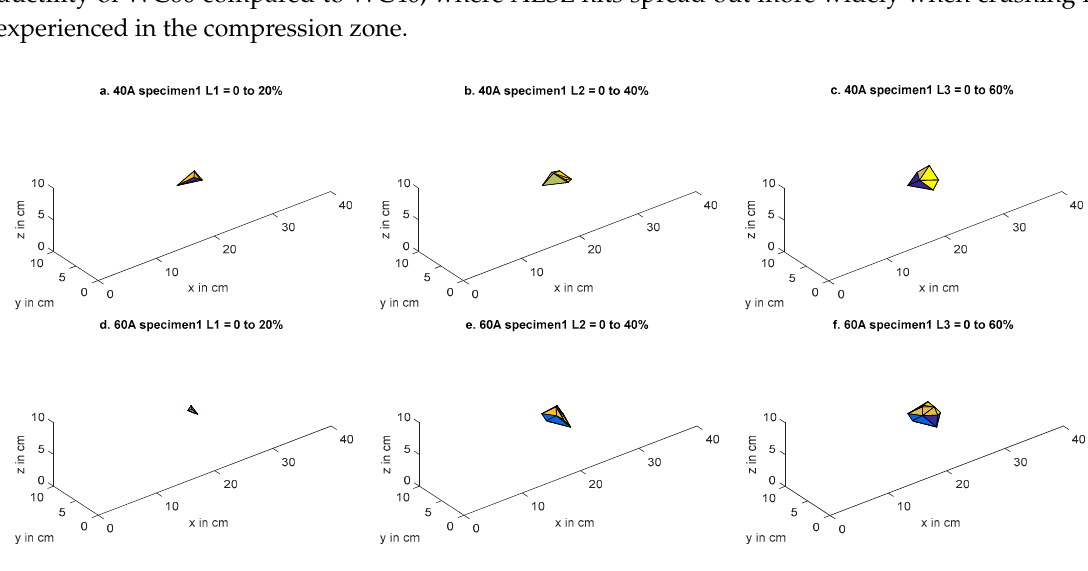
Figure 12. Convex hull volume (CHV) progression seen in space ( x -, y -, and z -axis) for L1, L2, and L3 for specimens WC40A1 ( a – c ), and WC60A1 ( d – f ).